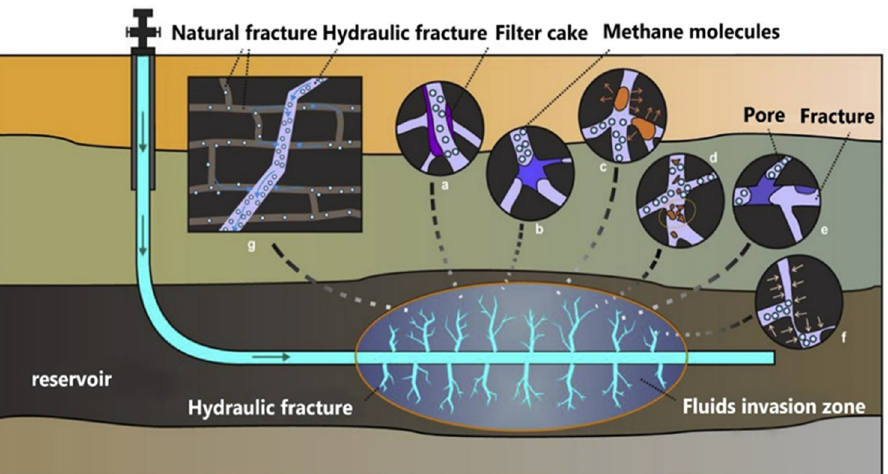
Figure 21. Fracturing stimulation and fracturing fluid damage: ( a ) compacted filter cakes are formed on the fracture surface, generated by fracturing. ( b ) After the filtrate enters the pore throat, the particles block the channel. ( c ) The filtrate causes the clay to expand, disperse and migrate, blocking the pores. ( d ) Some residual solid particles may cause throat blockage. ( e ) When the filtrate enters the fracture, it forms a concentrated liquid, preventing the gel from breaking. ( f , g ) GG adsorbs onto the fracture surface, resulting in a decrease in the porosity and permeability. (Reprinted/adapted with permission from Ref. [91], 2019, Huang et al.).